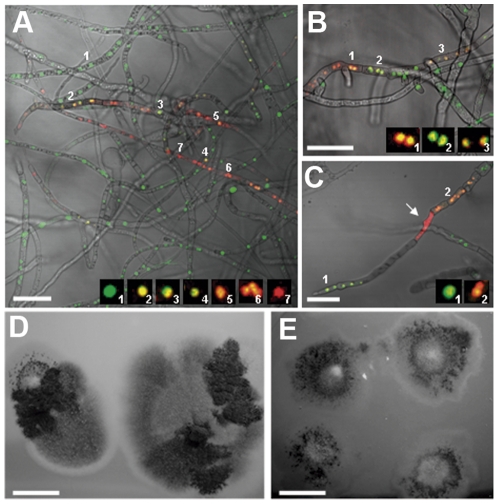
Heterokaryotic colony derived from a mixture of conidia from two incompatible strains that had undergone CAT fusion.(A) Nuclear distribution in the heterokaryotic colony was not uniform and green and red nuclei formed clusters. Insets show magnified images of nuclei with corresponding numbers in the lower magnification image. Yellow nuclei were present in the colony. The images of nuclei are shown as projections of z stacks of images with the green and red channels merged. (B) Another example of hyphae with nuclei of different colours. (C) A hypha undergoing apparent cell death, indicated by the red fluorescence dispersed throughout the cytoplasm (arrow) without any visible hyphal fusion nearby. Bars, 40 µm. (D) Subcultures of a heterokaryotic colony showing the formation of several distinct sectors. (E) Single conidial isolates exhibiting resistance to both Hyg and Phleo. Bar 15 mm.